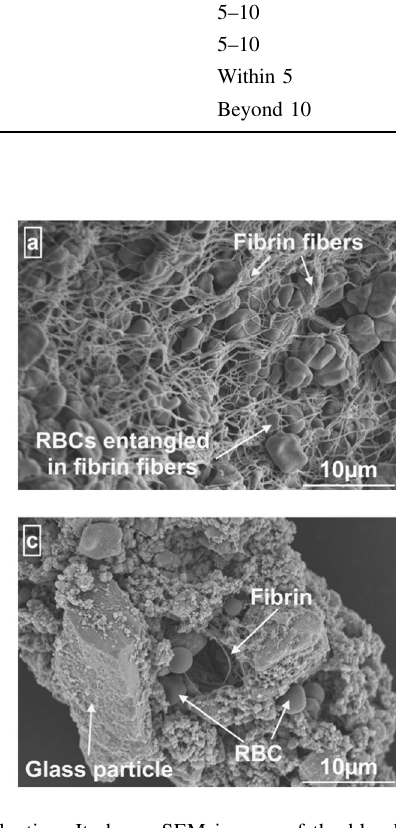
glass particles are seen to agglomerate with the RBCs and fi brin meshwork; and d high-resolution image of blood clot with Ta- MBG : the arrows represent the area where fi brin network is seen to connect with the glass particles; the area marked by a dotted circle shows a glass particle from which multiple fi brin fi bers seem to